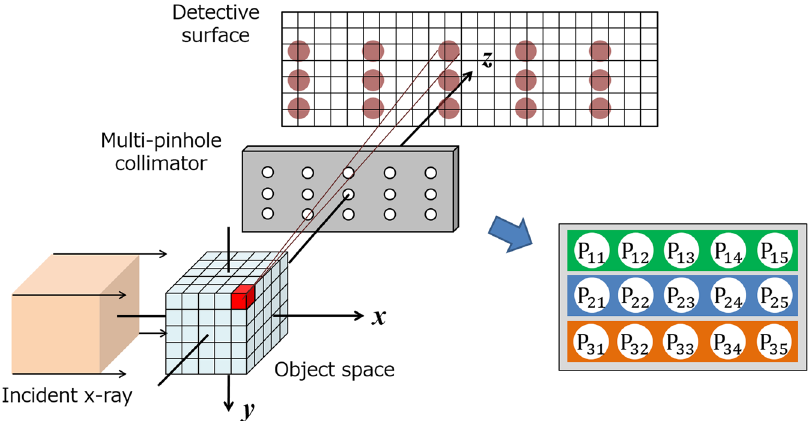
Figure 1. Schematic of the mp-FXCT imaging geometry and